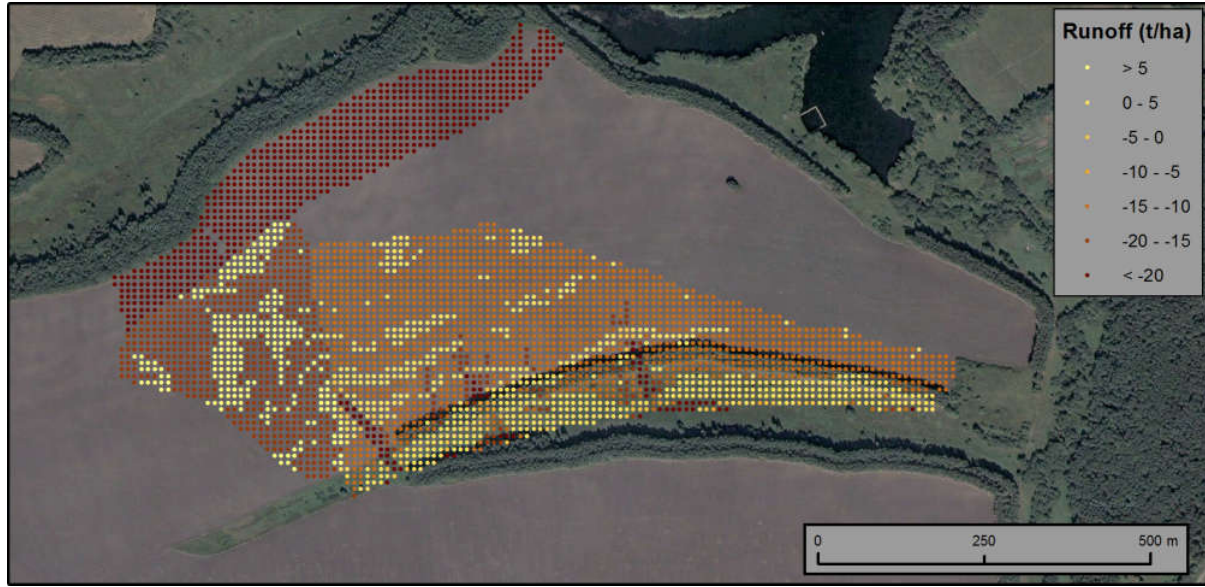
Figure 9 . A map of the runoff/accumulation intensity, estimations based upon the dependences of the caesium-137 activity on the catchment area and the sign of the profile curvature. Satellite image courtesy of DigitalGlobe